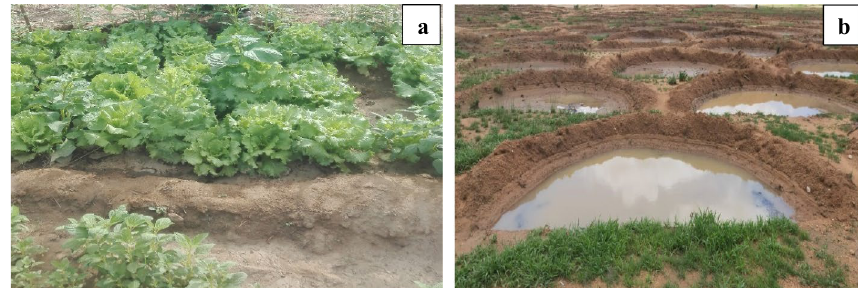
Fig. 4 Ridge farming ( a ) and half-moon ( b )